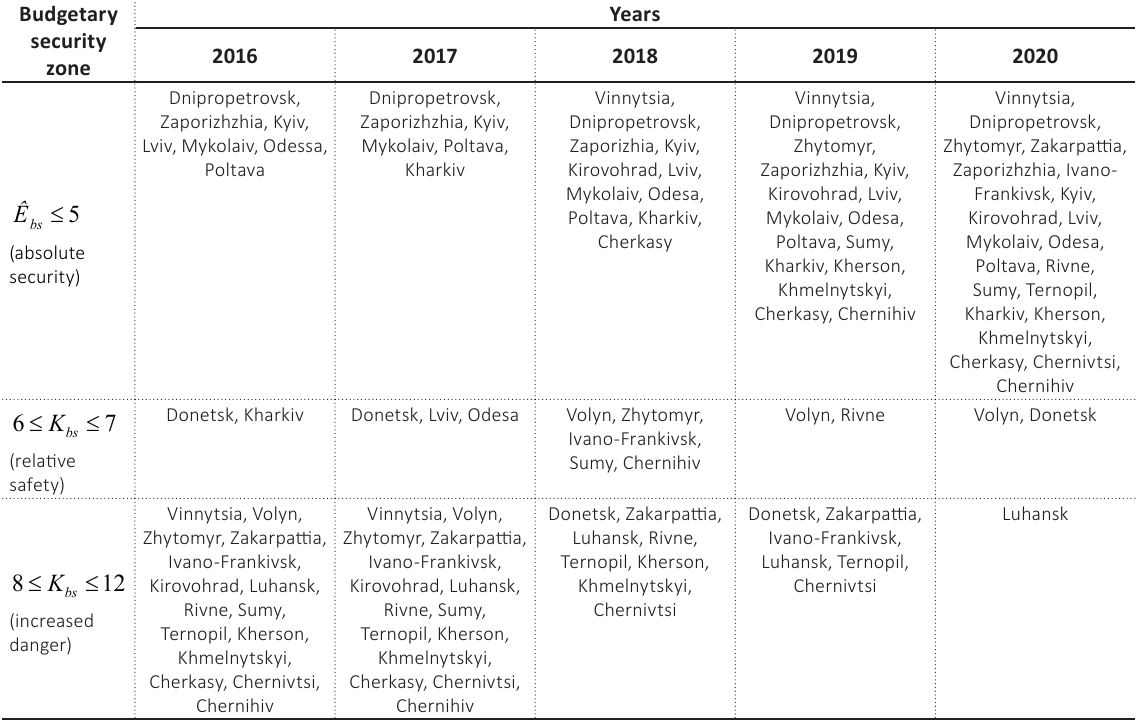
Table 4. Grouping of regions by the level of budgetary security,